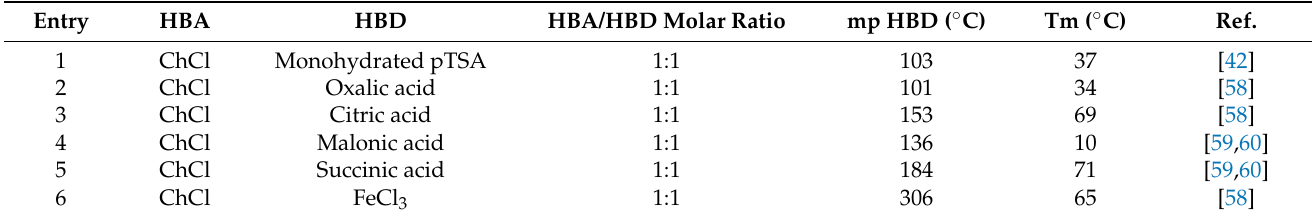
Table 5. Deep eutectic solvents investigated in the present